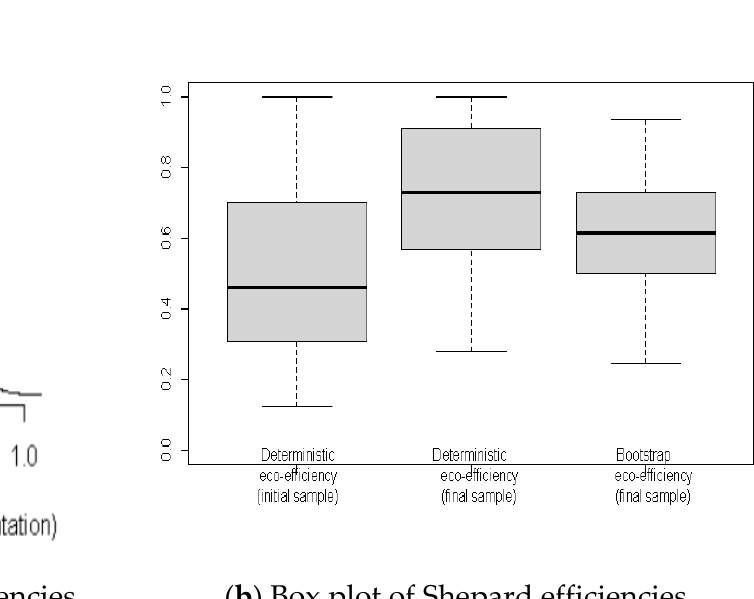
Table 3. Results of the model applied to second-stage estimations.